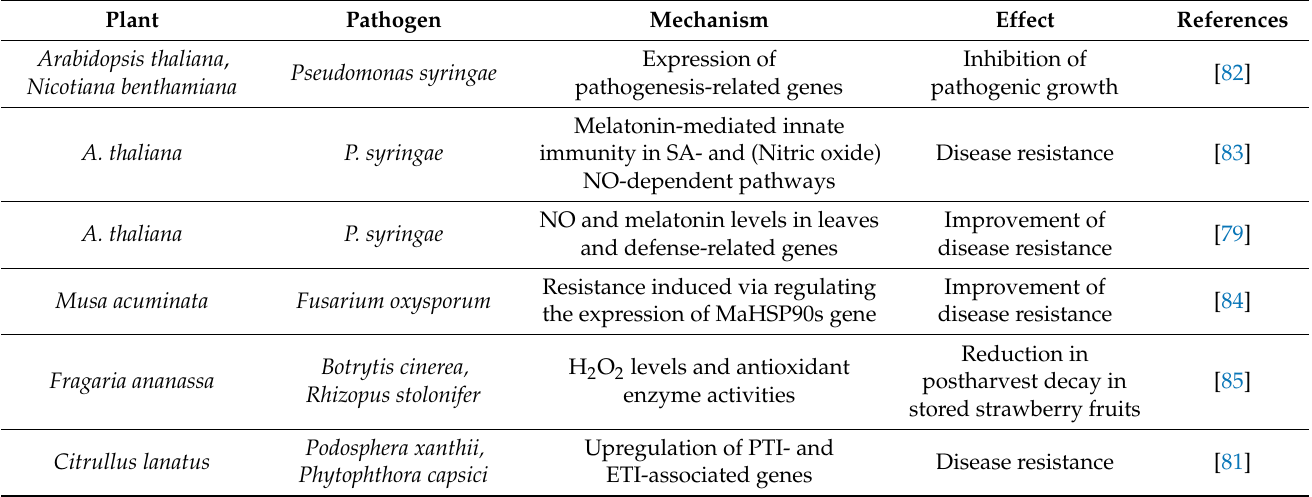
Table 1. Role of exogenously applied melatonin in plant–microbe